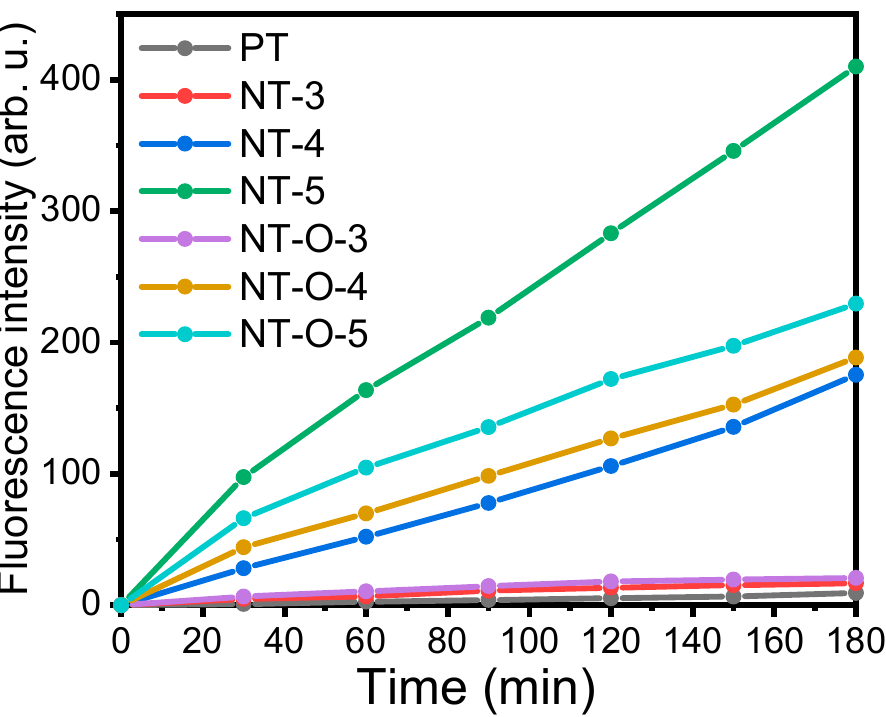
Figure 7. Temporal hydroxyl radical formation using coumarin probe method. To set the initial value of fluorescence intensity to zero, values at each time interval are subtracted with the corresponding initial intensity, i.e., at t = 0 min.